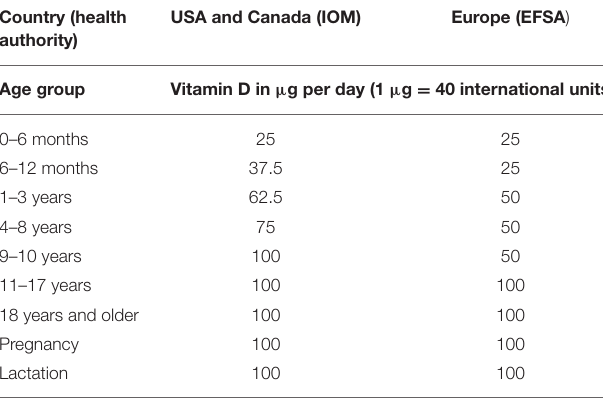
TABLE 2 | Tolerable upper intake levels for vitamin D. Country (health